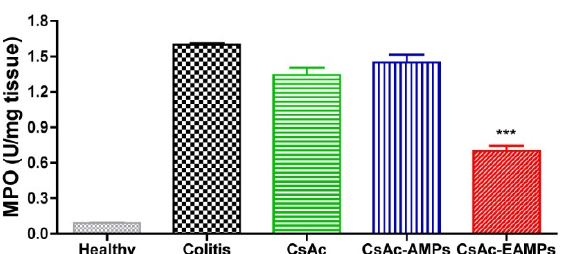
Figure 7. MPO activity in colon samples treated with or without CsAc formulations. *** denotes p < 0.001 compared with the untreated colitis group. Data are presented as means ± standard deviation ( n = 8). CsAc, cyclosporine A crystals; CsAc-AMPs, CsA crystal-loaded alginate microparticles; CsAc-EAMPs, CsA crystal-loaded, Eudragit S 100 coated alginate microparticles; MPO, myeloperoxidase.